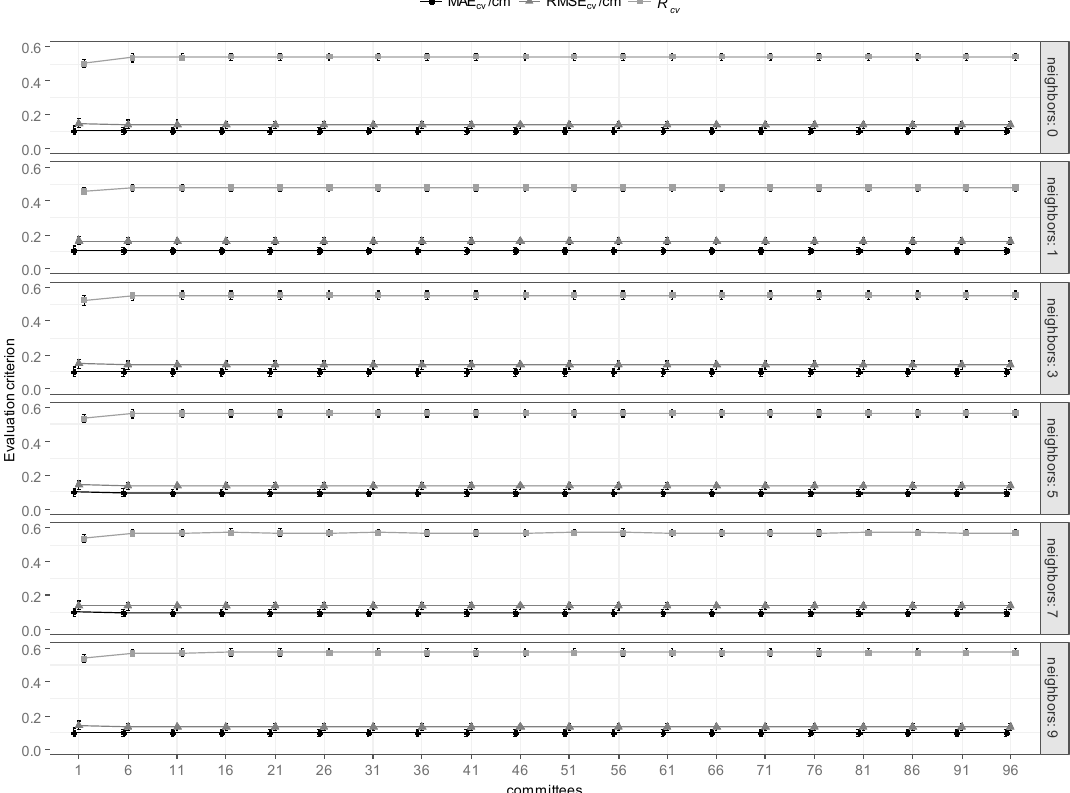
Figure 3. Tuning Cubist—the effect of neighbors and committees on Cubist model performance. The tenfold cross-validation was used for validating. The error bar is standard deviation. The parameters, committees and neighbors, are the number of iterative model trees to grow in sequence and the number of neighboring training points which can be used to adjust the optimal predictions, respectively.